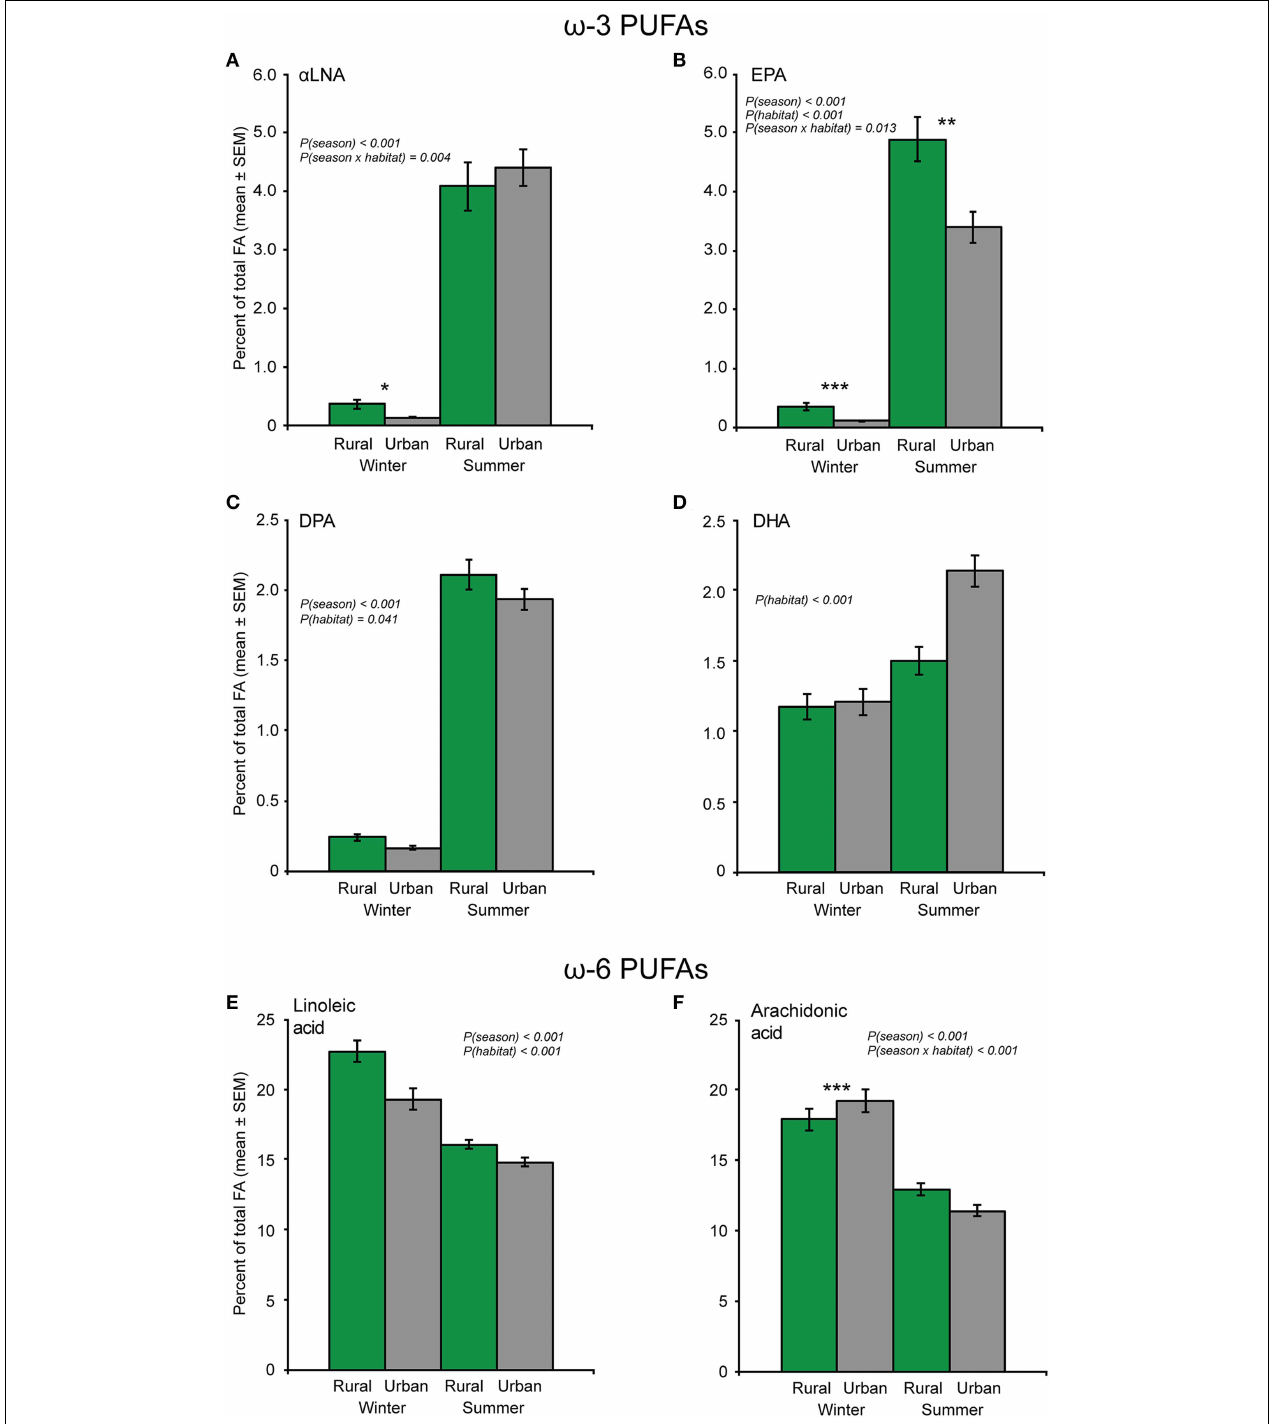
by the p -values. When the season × habitat interaction was significant, fatty acid (FA) proportions of birds from the two habitats were also analyzed separately for each season, and significant differences between habitats within a season are indicated by asterisks ( * p < 0 . 05 ; ** p < 0.01; *** p < 0 . 001 ). Note that the Y-axis scale differs between figure panels.